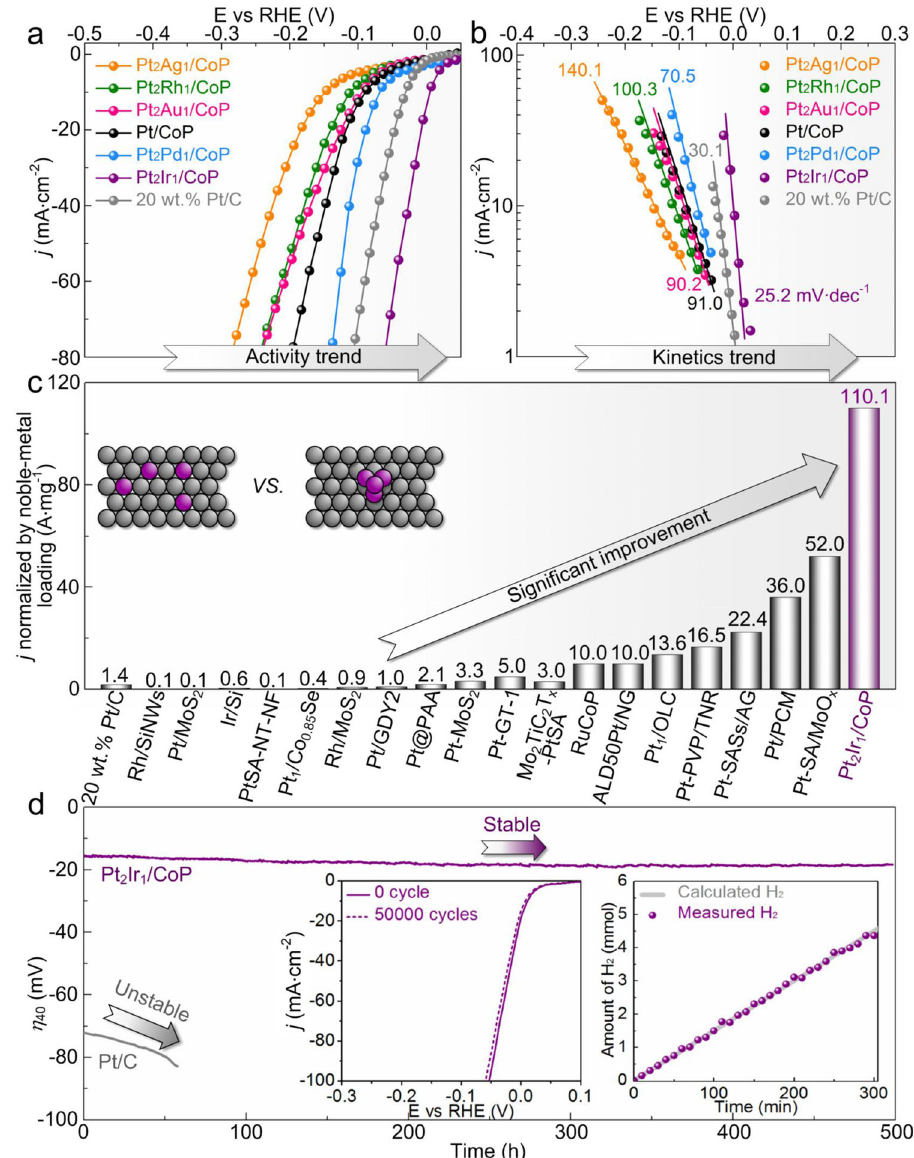
Fig. 4 Catalytic evaluation of PtM/CoP with a total metal loading of 1.0 wt % in 0.5 M H 2 SO 4 . a LSV curves of various Pt 2 M 1 /CoP and Pt/CoP catalysts (1.0 wt %) and Pt/C (20 wt .%) benchmarks. b LSV – derived Tafel plots for various catalysts. c Comparisons of the noble-metal utilization activity of Pt 2 Ir 1